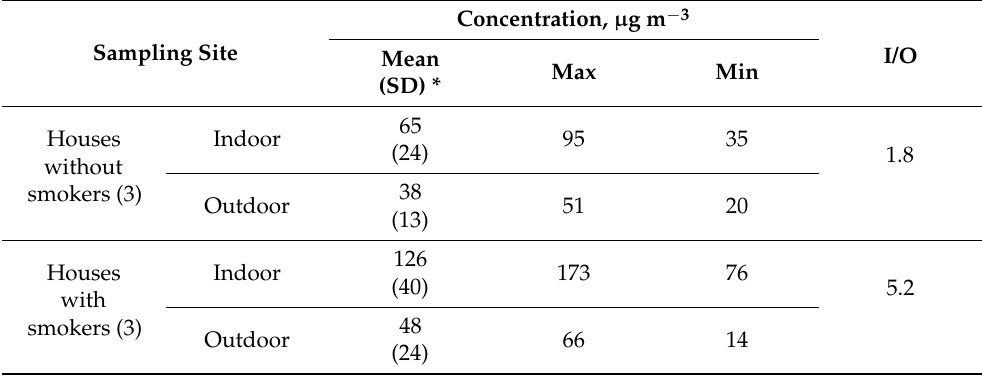
Table 2. Concentration of PM 4 indoors and outdoors for the single-family houses without and with smoking residents in